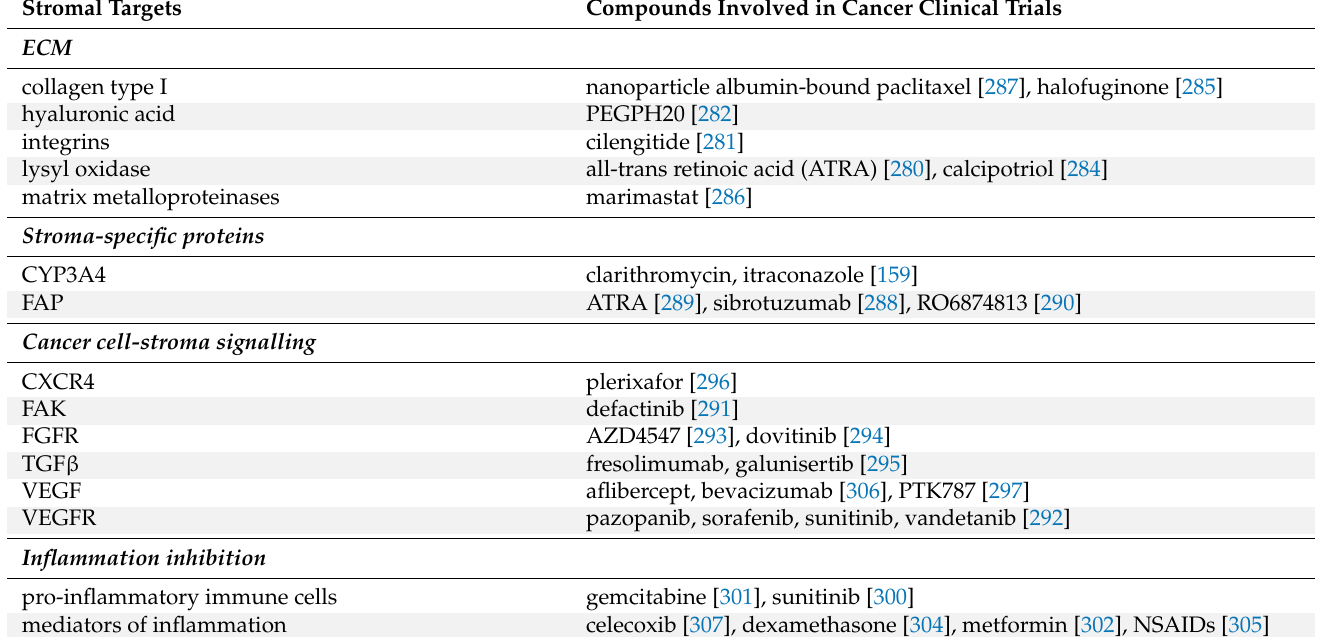
Table 3. Agents explored in clinical trials targeting the tumour